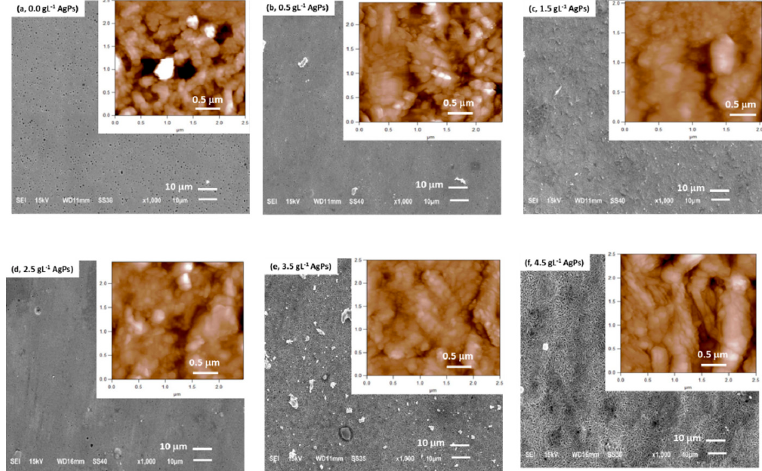
Figure 1. SEM and AFM (insets) images of Zn/AgP composite coatings obtained from different electrolytes: ( a ) S 0 (= 81 g·L − 1 ZnCl 2 + 25 g·L − 1 H 3 BO 3 , + 208.8 g·L − 1 KCl + 1.5 g·L − 1 PEG 8000 + 0.2 g·L − 1 BDA + 0.03 g·L − 1 cetyl trimethylammonium hydrogen sulphate (CTHS) + 2.8 g·L − 1 triethanolamine), + 0.2 g · L − 1 BDA + 0.03 g · L − 1 cetyl trimethylammonium hydrogen sulphate (CTHS) + 2.8 g · L − 1 triethanolamine), ( b ) S 0 + 0.5 g · L − 1 AgP, ( c ) S 0 + 1.5 g · L − 1 AgP, ( d ) S 0 + g · L − 1 AgP, ( e ) S 0 + 3.5 g · L − 1 AgP, ( f ) S 0 + 4.5 g · L − 1